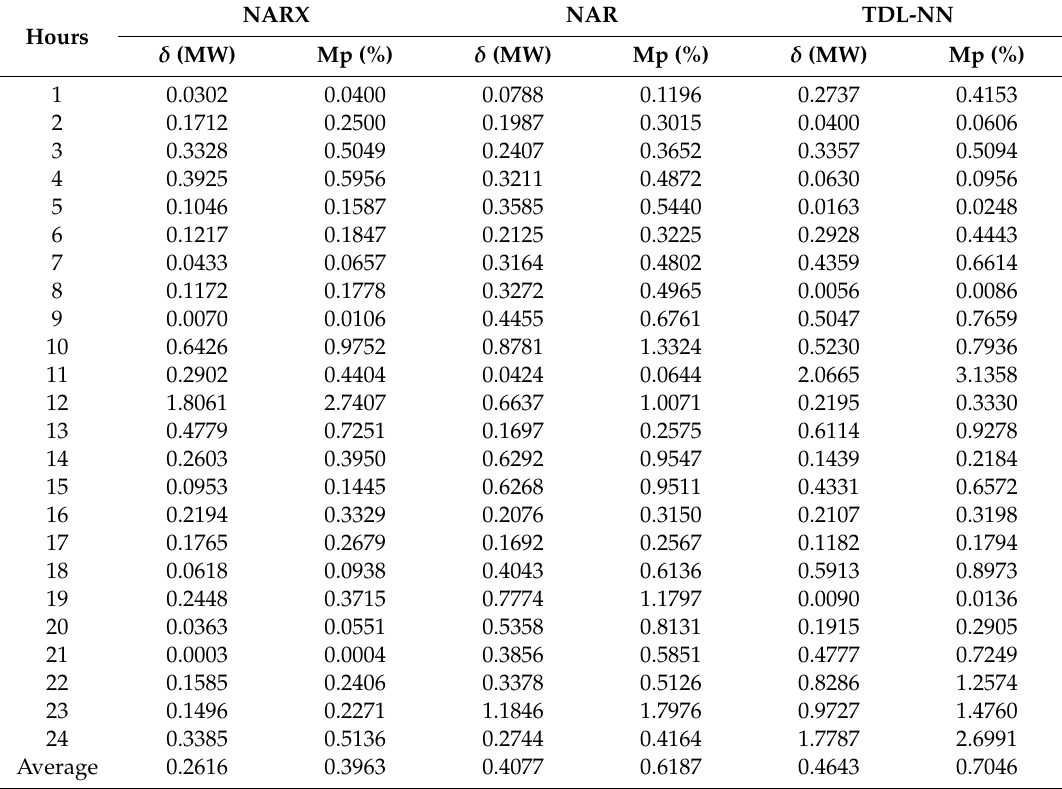
Table A2. Comparison of 24 h load